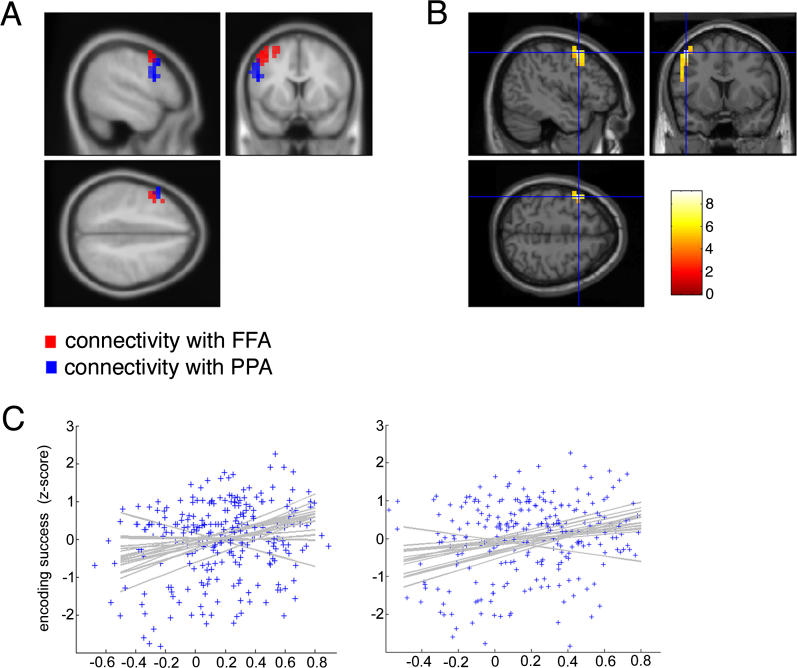
Functional Connectivity(A) Voxels exhibiting significant (
p < 0.01, cluster size > 62 5mm
3) functional connectivity with the FFA (red) and PPA (blue).
(B) Voxels exhibiting significant (
p < 0.01, cluster size > 625 mm
3) functional connectivity with the average of the FFA/PPA ROI. The blue crosshairs mark the peak voxel (
t = 4.57,
p < 0.001), and the color scale refers to
t values.
(C) Scatterplots of the correlation between connectivity (timeseries correlation
r value) and encoding success (Fisher's
z score) for the peak voxel in the PFC correlating with the FFA (left panel) and PPA (right panel). Each blue cross is one participant/block; gray lines are the fit of the correlation for each participant.